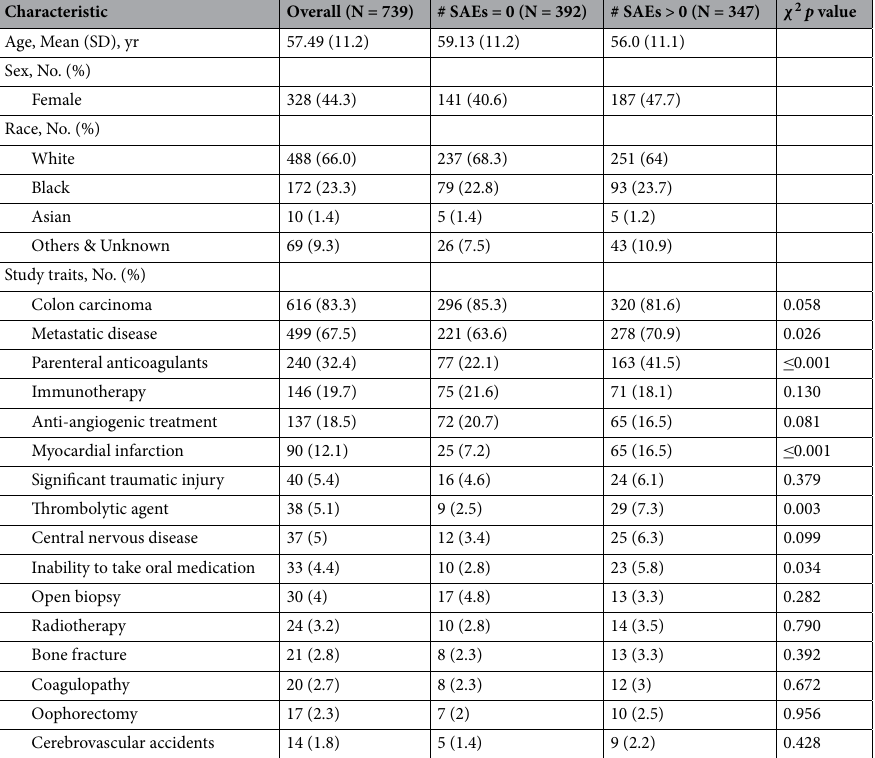
Table 2. Demographic characteristics and selected traits of the target population of the bevacizumab clinical trial for CRC.